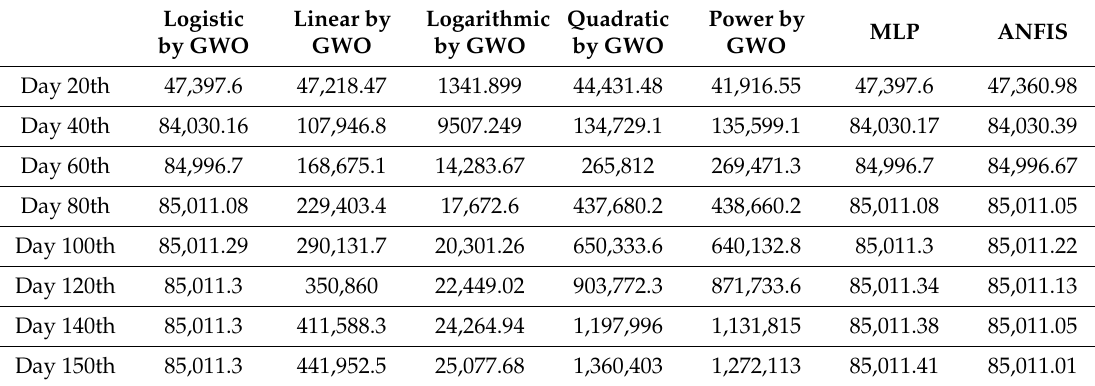
Table 18. The outbreak prediction for China through 150 days.